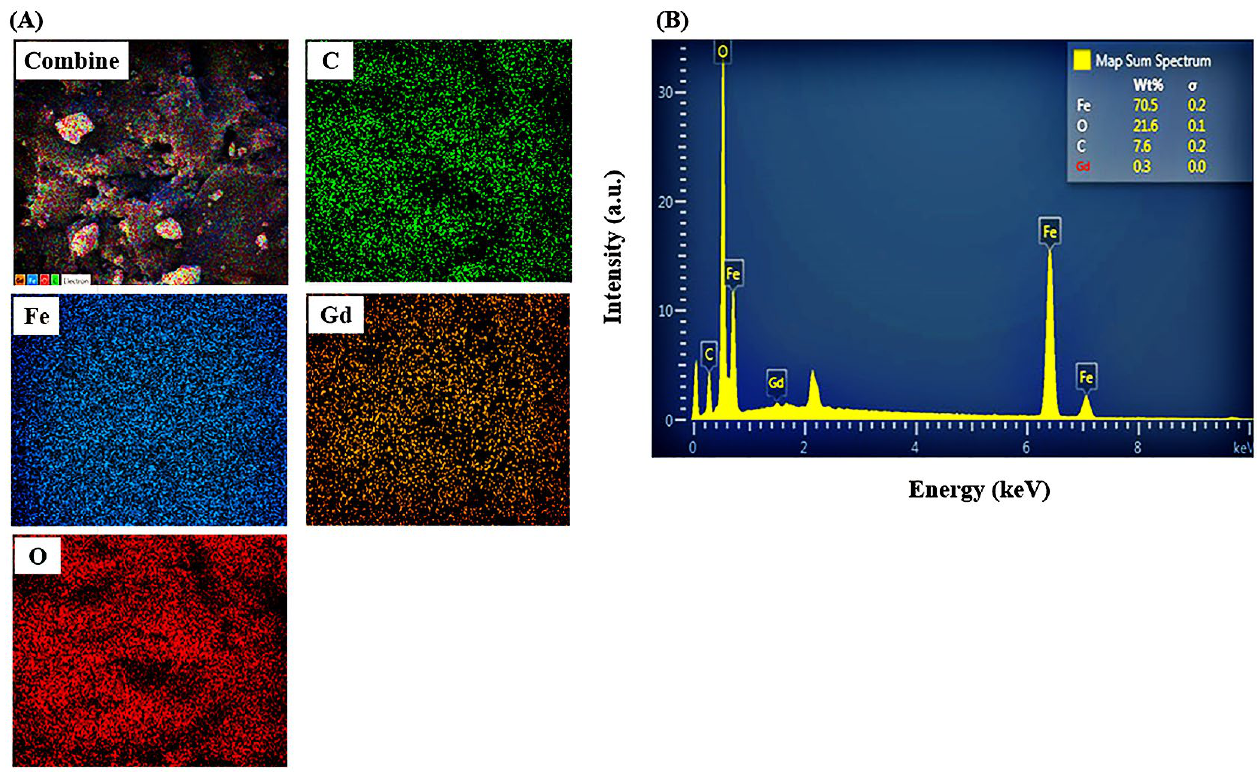
Figure 4. Elemental mapping ( A ) and EDAX ( B ) spectrum of the synthesized magnetite/Gd 3+ /β - cyclodextrin nanoplatform.